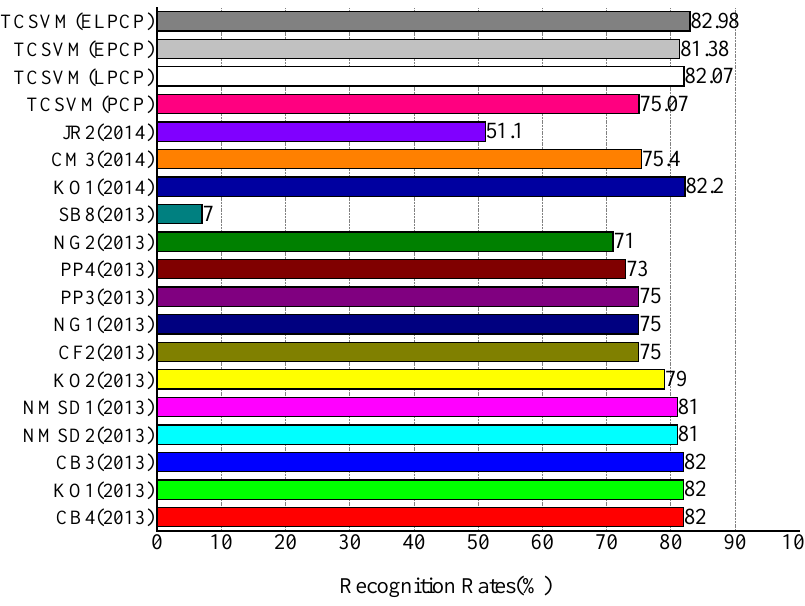
Figure 9. Comparison of recognition rates with state-of-the-art methods on Mirex’09 dataset.